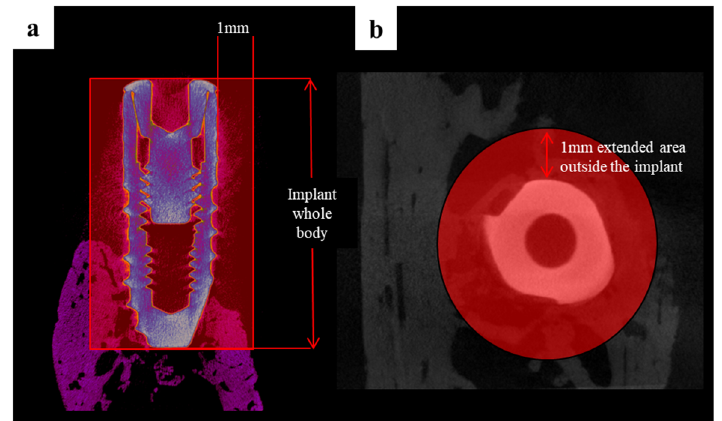
Figure 15. The region of interest in micro-computed tomography (micro-CT) images: ( a ) Coronal section view; ( b ) Horizontal section view.